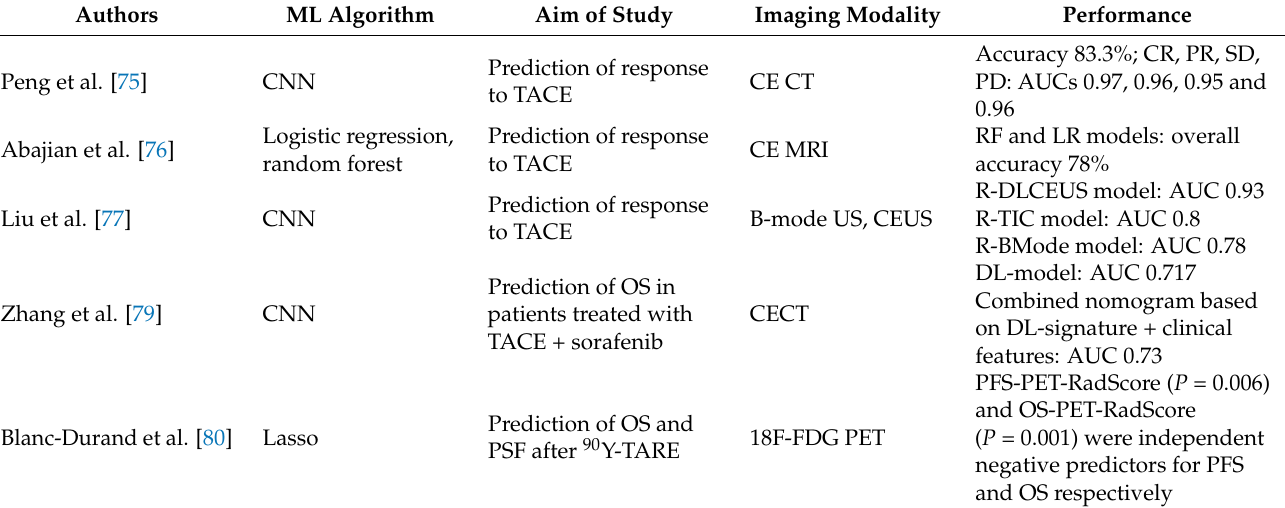
Table 6. Overview of ML algorithms applied to trans-arterial therapies response